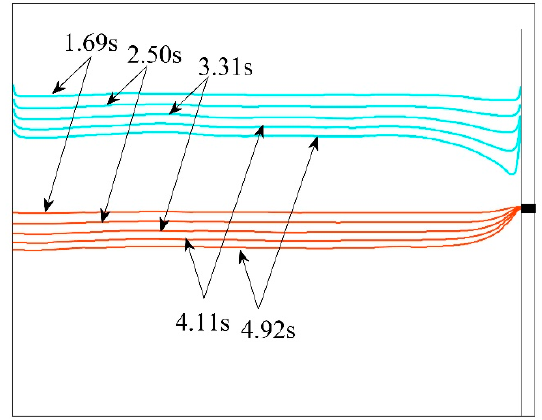
Figure 4. Interfaces between oil and gas (l–g, blue lines) and water and oil (l–l, red lines) at five different moments during a draining experiment.